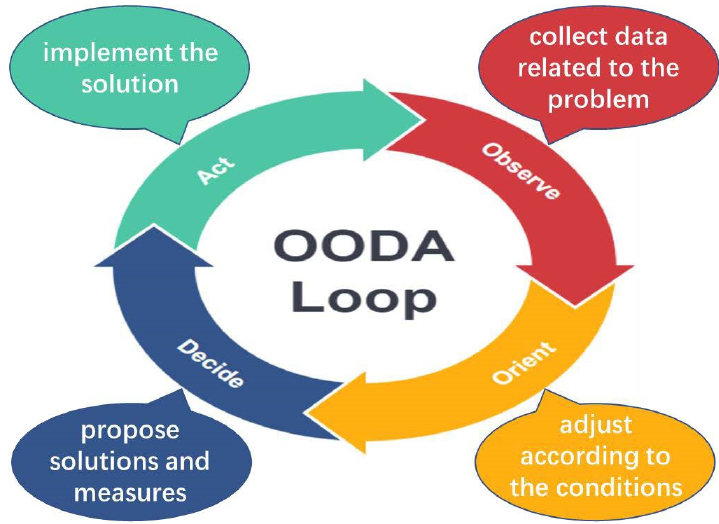
Figure 3. Theoretical framework of OODA loop.